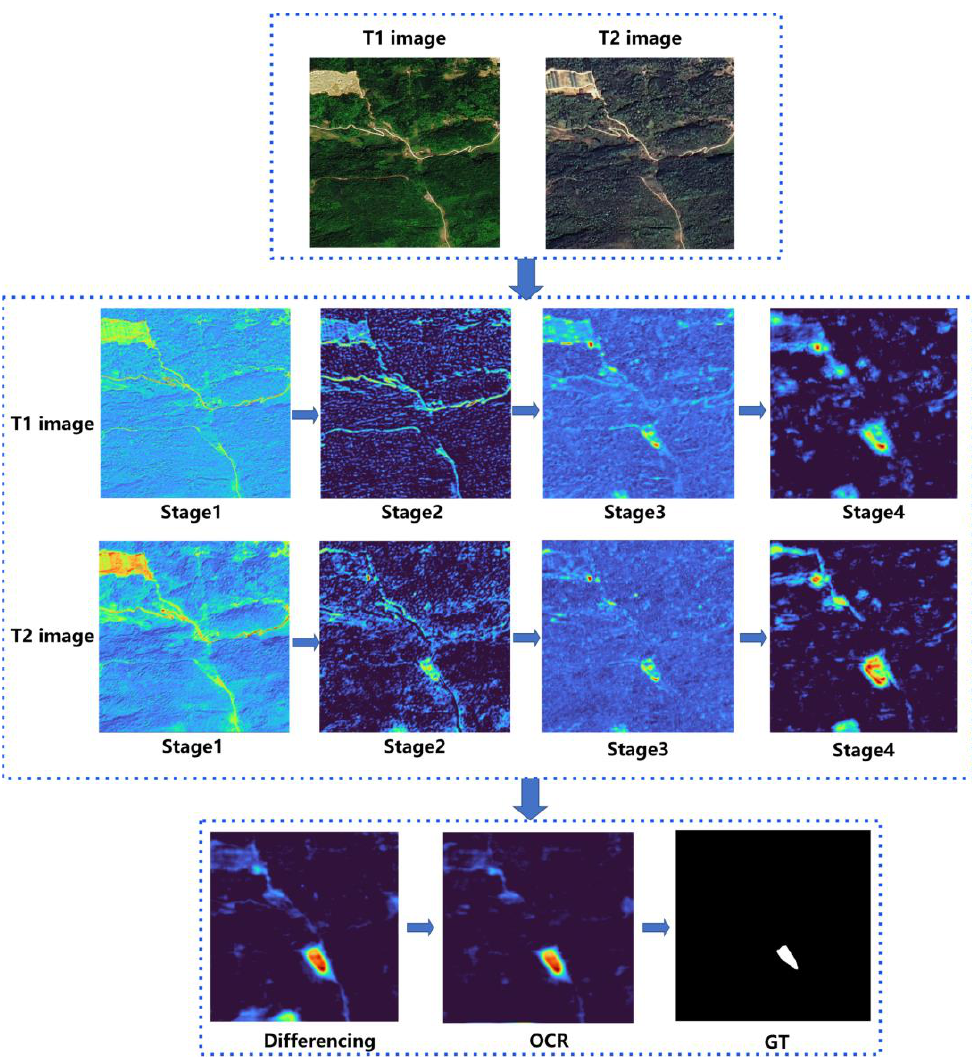
Figure 10. Visualization of a deep feature at a different layer of